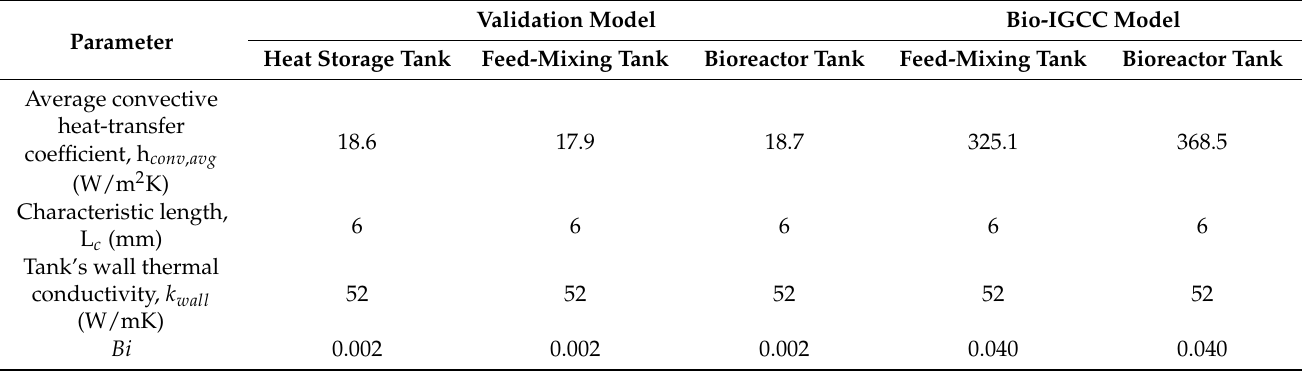
Table 7. Calculated Bi and parameter value for Bi calculation.